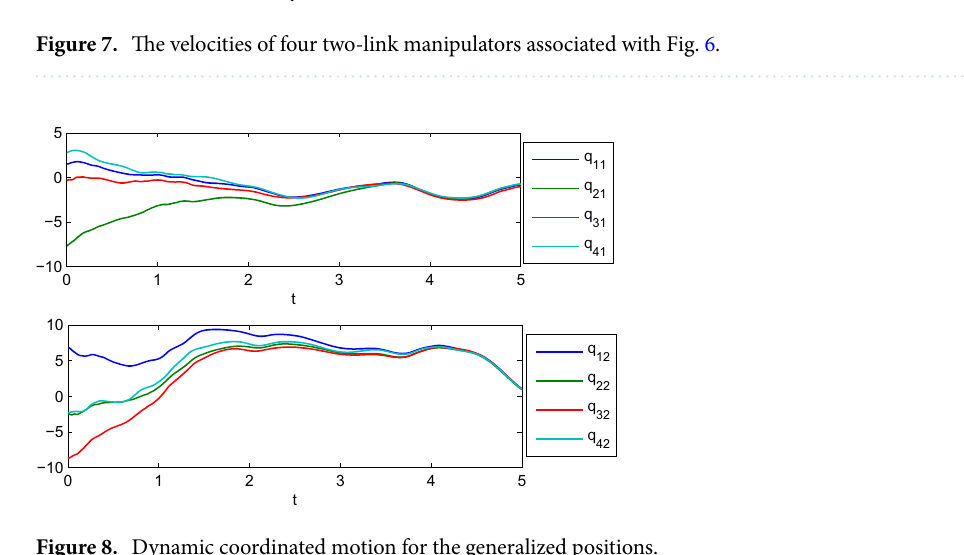
Figure 8. Dynamic coordinated motion for the generalized